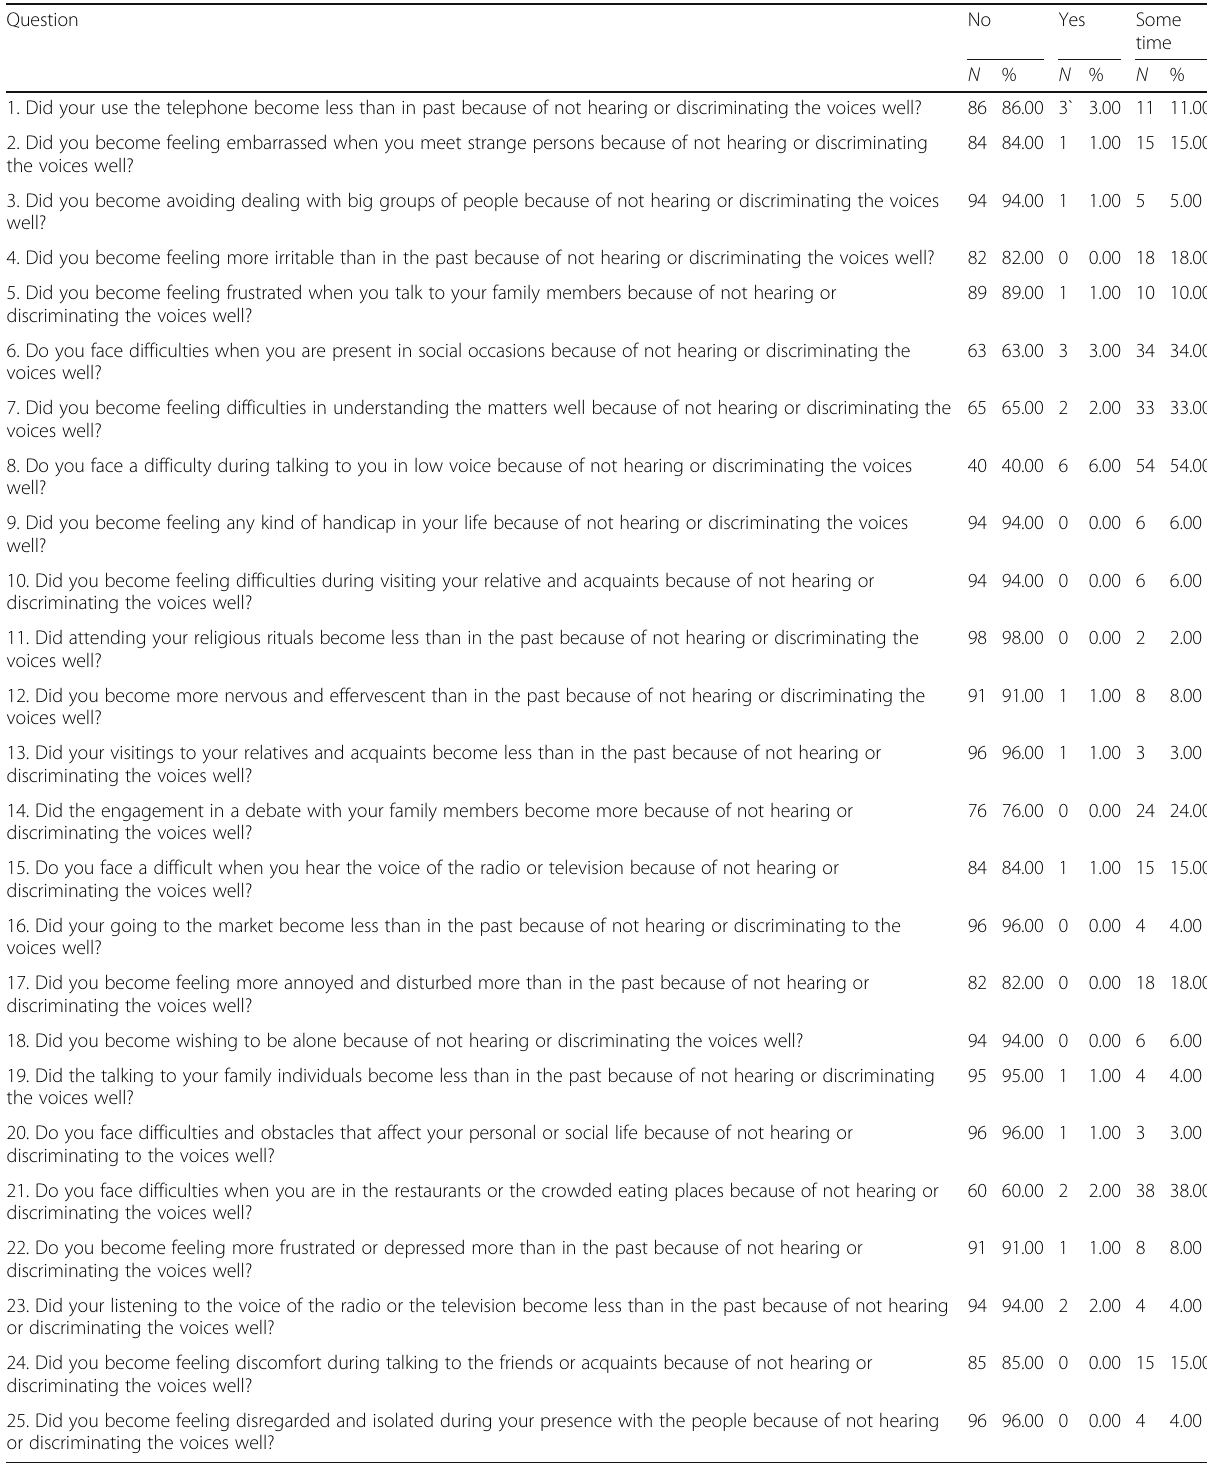
Table 3 Total responses for each question